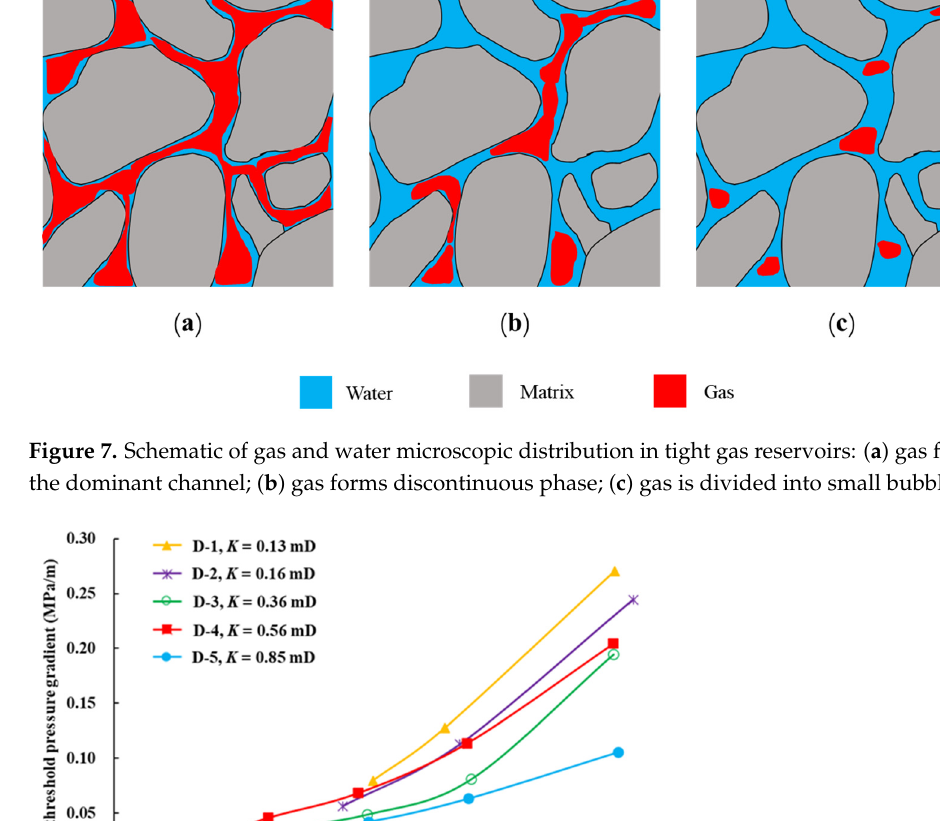
Figure 7. Schematic of gas and water microscopic distribution in tight gas reservoirs: ( a ) gas flows in the dominant channel; ( b ) gas forms discontinuous phase; ( c ) gas is divided into small bubbles.